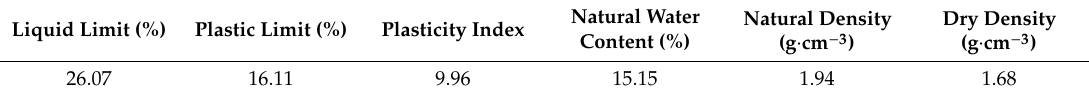
Table 1. Properties of silty soil.